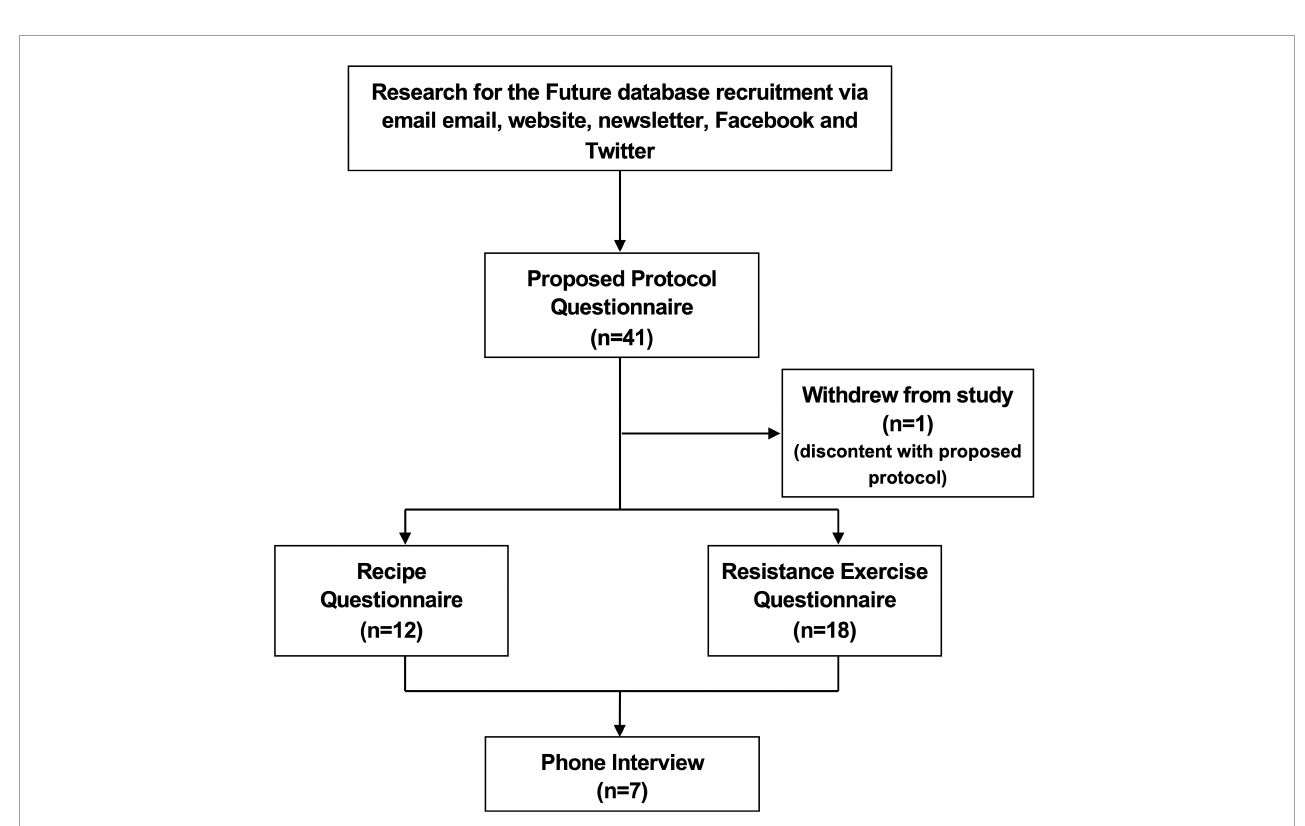
FIGURE1 Study flow